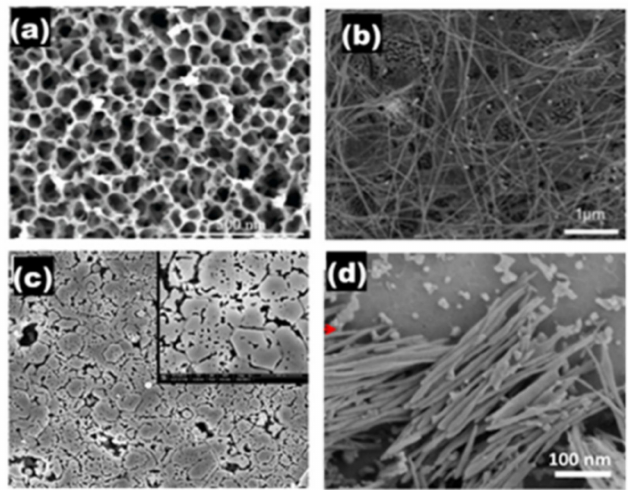
Figure 5. SEM images of ( a ) porous GaN, ( b ) GaN nanowires, ( c ) porous InGaN, and ( d ) InGaN nanowires. Reproduced from [38,51,60,61], with permission respectively from Copyrights IOP Publishing, 2013, The Optical Society (OSA), 2012, Elsevier, 2013, and Elsevier, 2017.